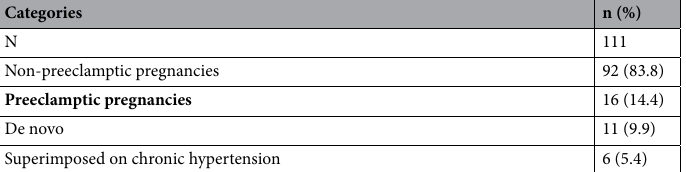
Table 3. Prevalence of preeclampsia among the study participants. De novo: preeclampsia with hypertension developed after 20 weeks of gestation 26 . Superimposed: preeclampsia with pre-pregnancy hypertension or